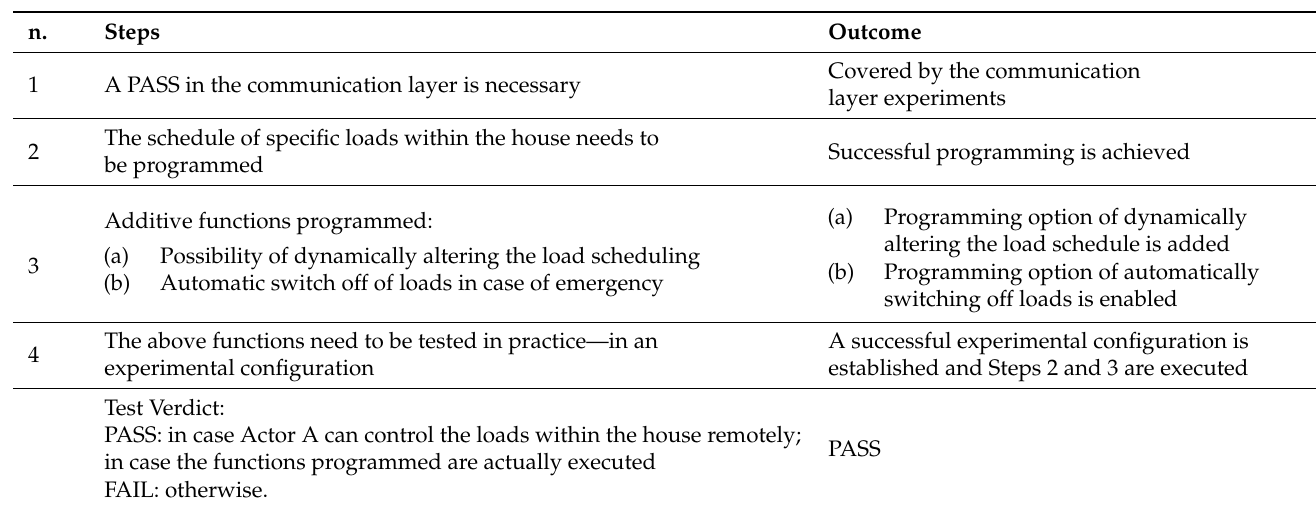
Table 7. Steps for communication layer interoperability and outcome of